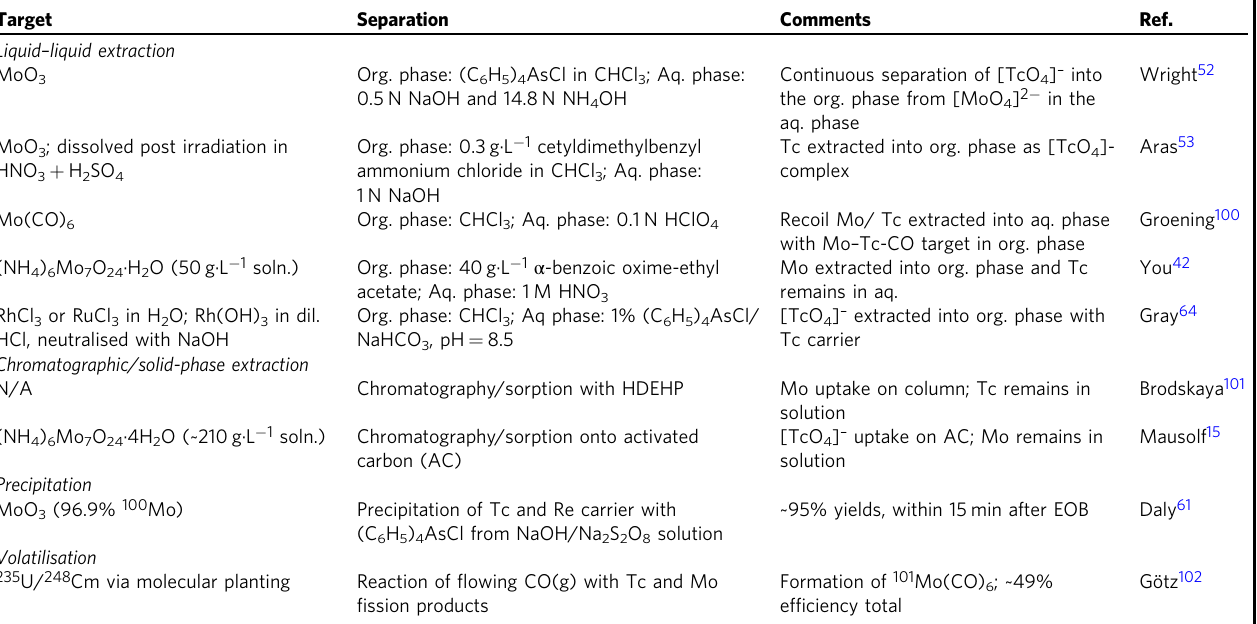
Table 5 Separation methods for obtaining 101